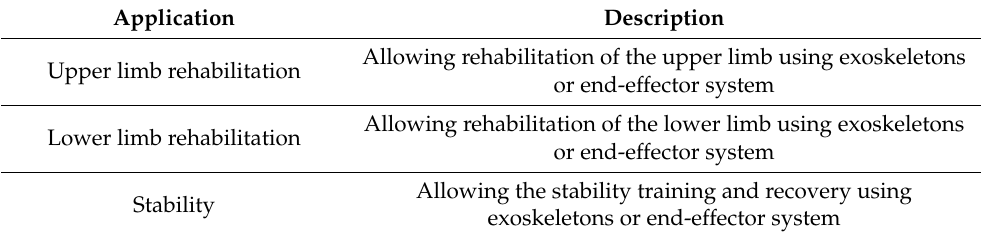
Table 1. Classification of the rehabilitation robot according to the